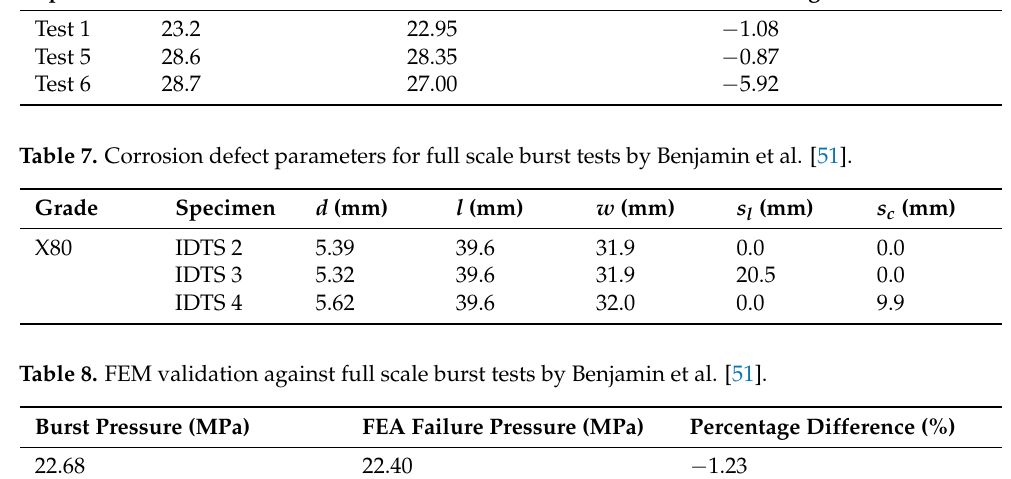
Table 6. Finite element method (FEM) validation against full scale burst tests by Bjorney et al. [50].